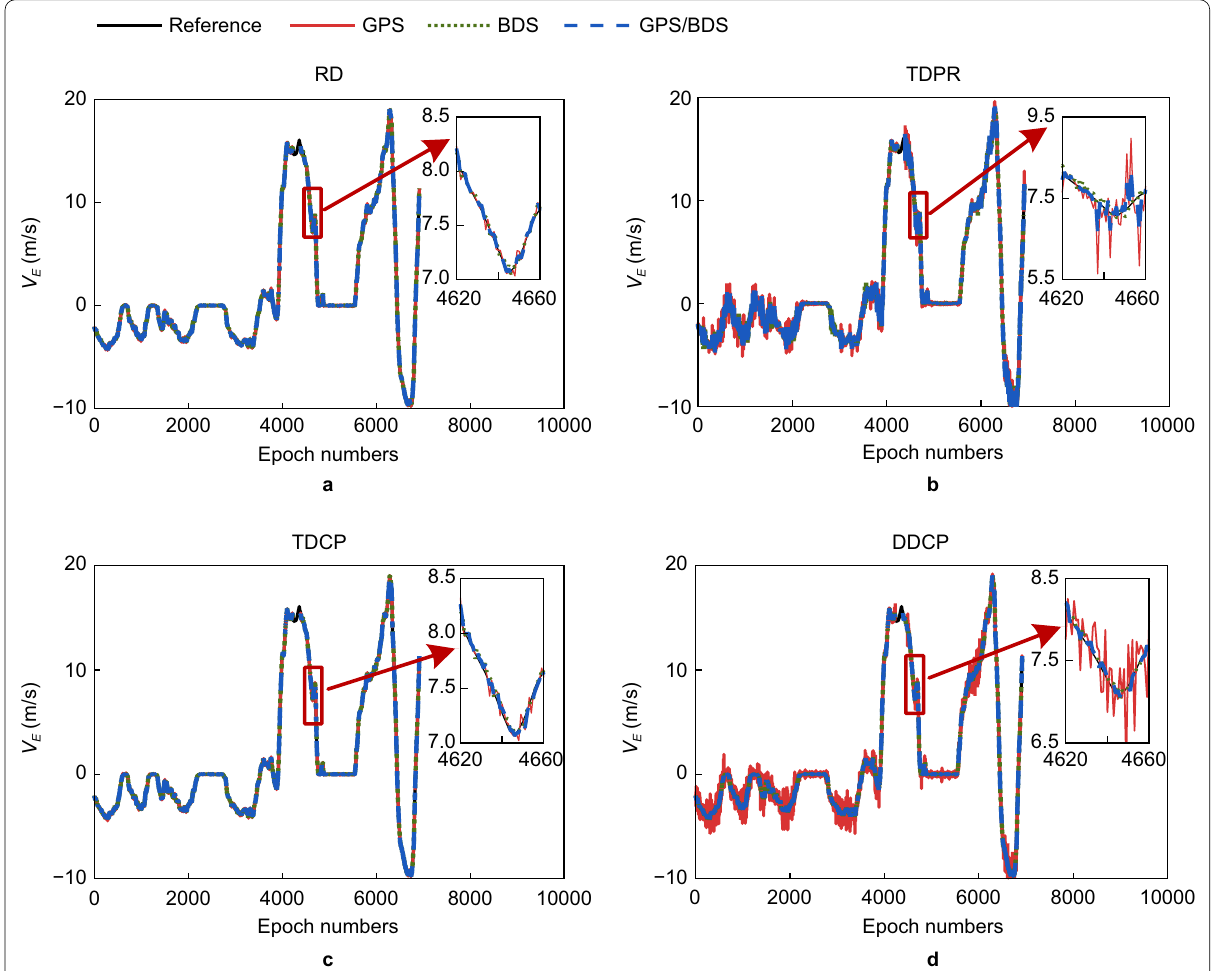
Fig. 6 Velocity determination results and zoomed-in windows in east component with the RD- ( a ), TDPR- ( b ), TDCP- ( c ) and DDCP- ( d ) based methods in test